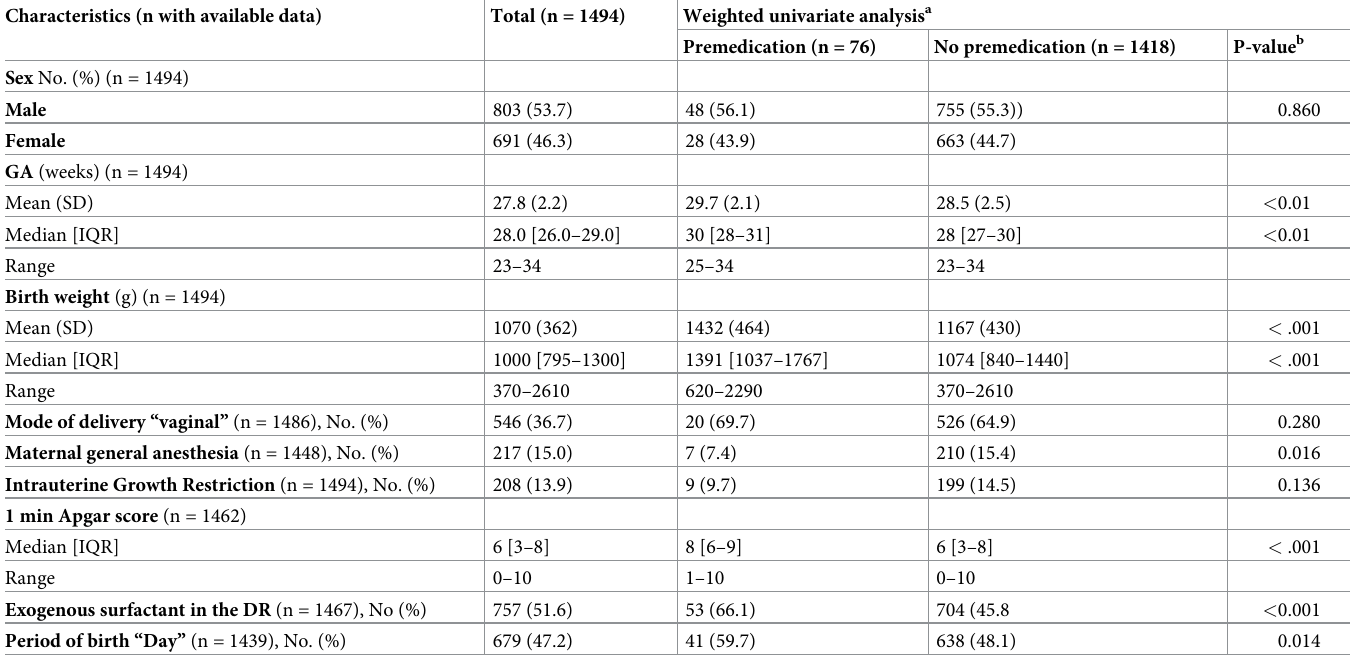
Table 2. Population characteristics and weighted univariate analysis of risk factors associated with premedication use. Characteristics (n with available data)